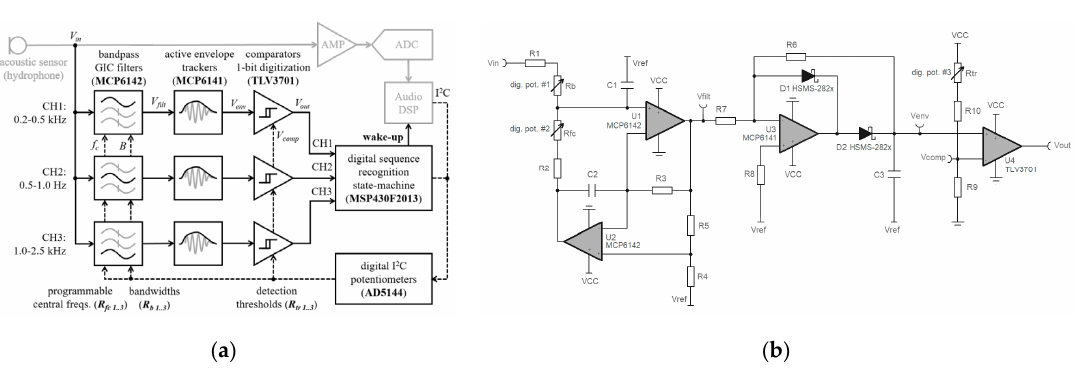
Figure 1. The 3-channel always-on wake-up interface. ( a ) Architecture; ( b ) Design of an individual analog channel (GIC filter, active envelope tracker,